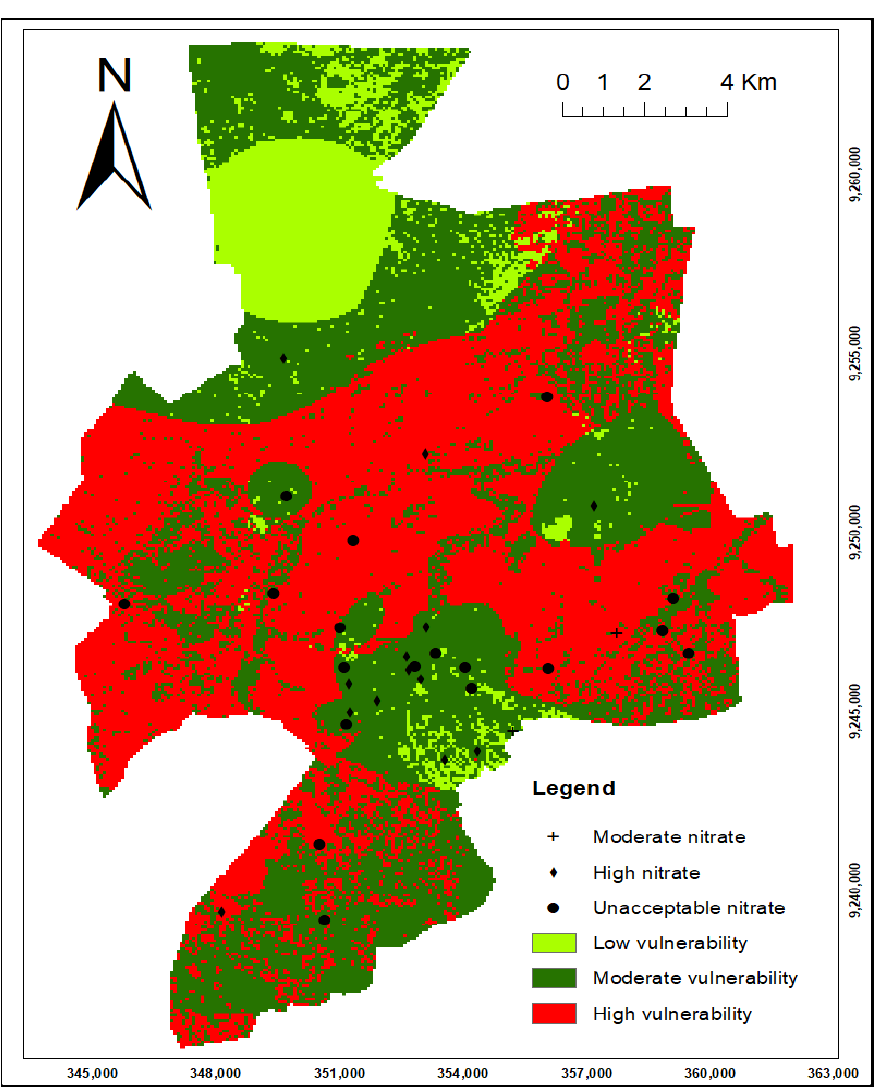
Figure 14. DRASTIC-LU/LC model and nitrate concentration.